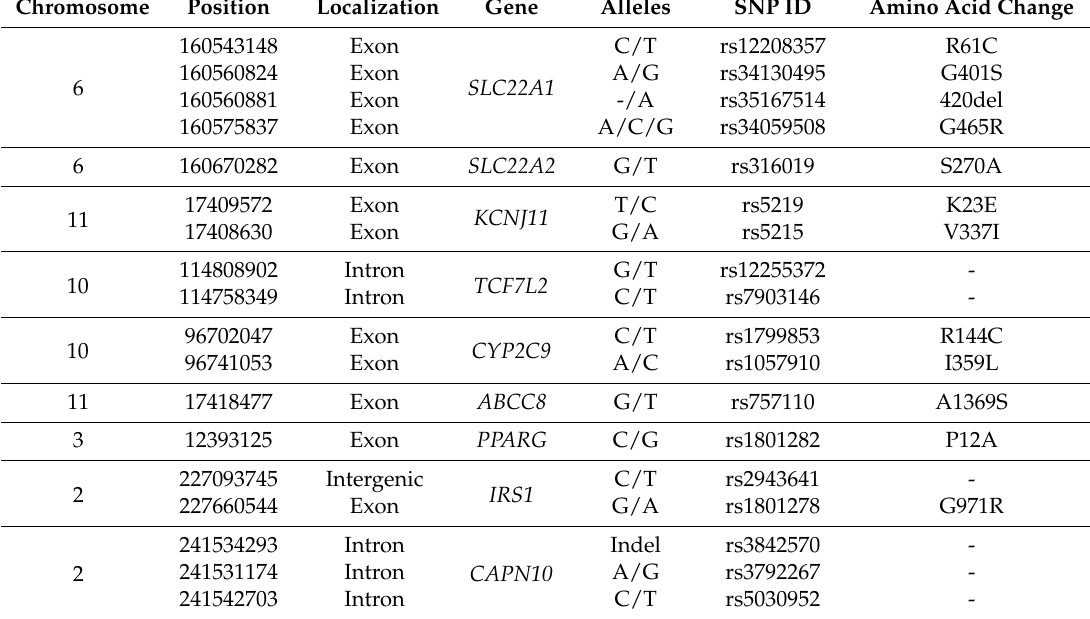
Table 1. Type 2 diabetes (T2D) drug responsiveness associated Single Nucleotide Polymorphisms (SNPs).